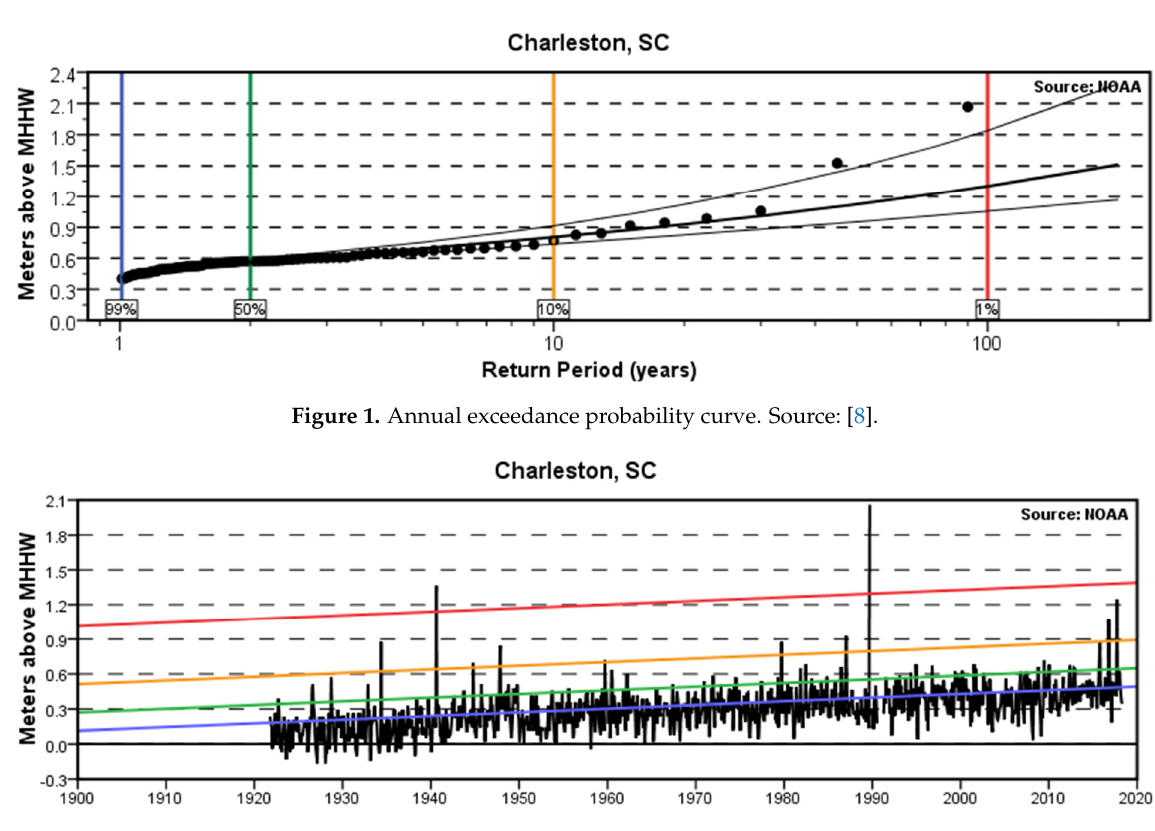
Figure 2. Extreme water levels. Source: [12] Note: The red line is the 1% surge, the yellow line is the 10% surge, the green line is the 50% surge, and the blue line is the 99% surge. The lines slant upwards to take into account sea level rise over time.